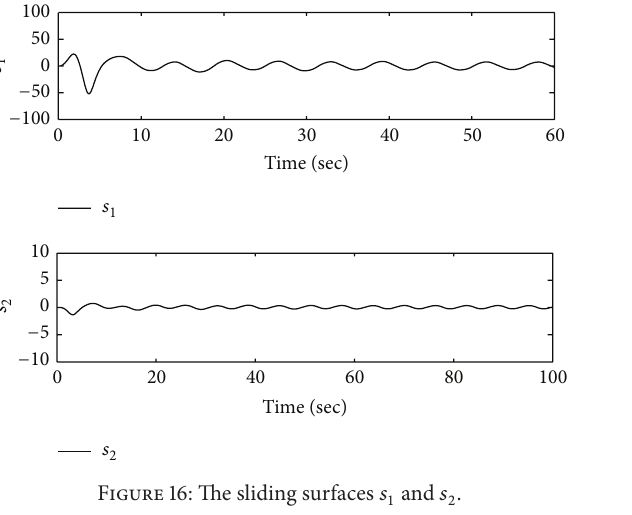
Figure 19: The tracking performances of 𝑥 and ̇𝑥 .